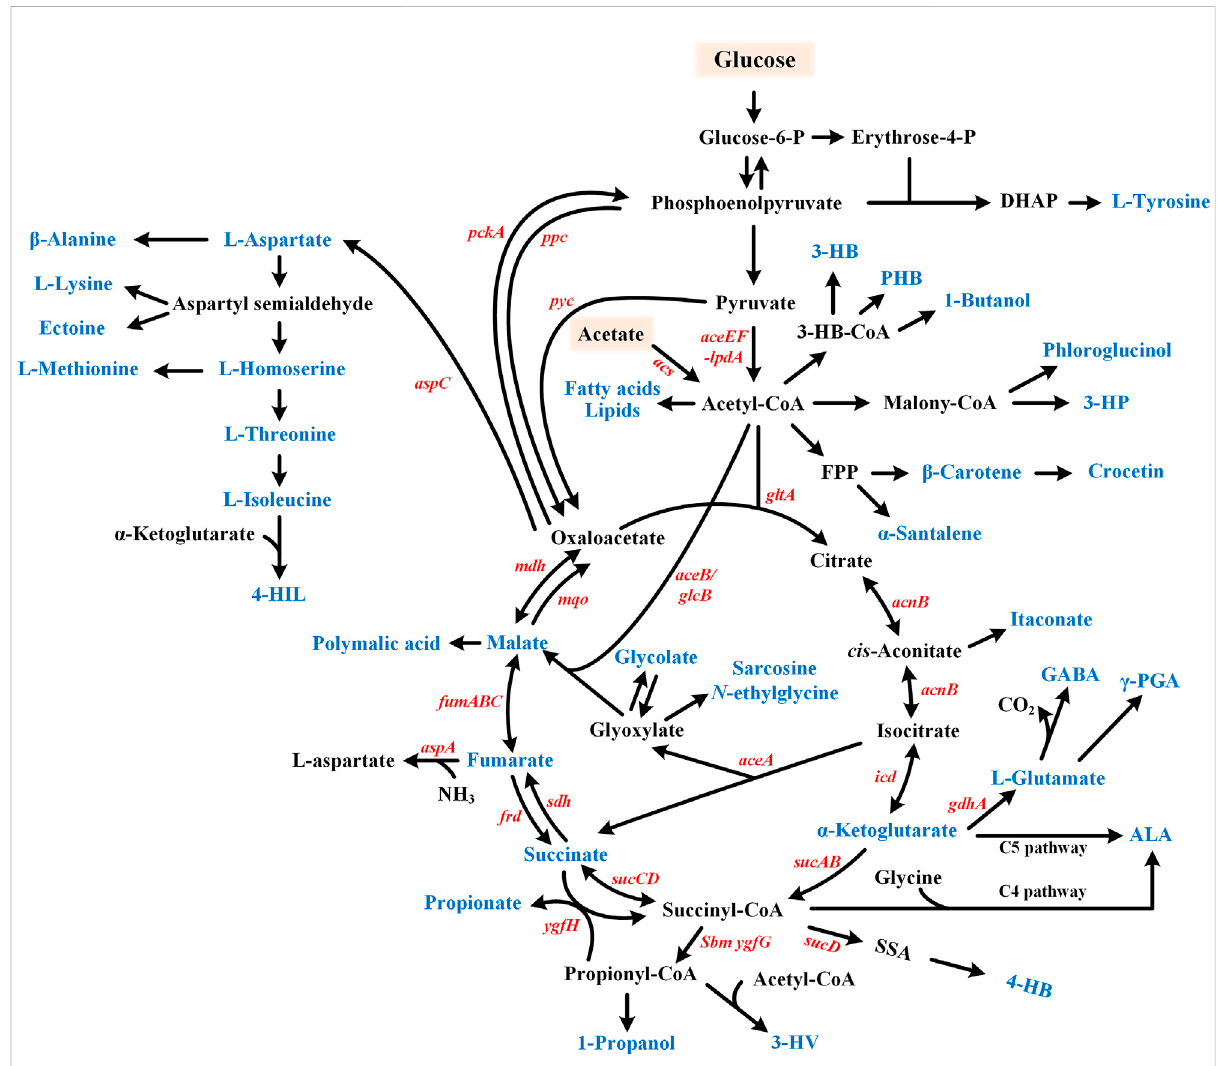
FIGURE 3 Metabolic pathway for the glyoxylate cycle involved chemicals production. Target products include organic acids, amino acids, fatty acid- relatedchemicals,etc.andareshowninblue.Glucoseoracetatecanbeusedassubstrates.GABA, γ -aminobutyricacid;4-HIL,4-hydroxyisoleucine; ALA, 5-aminolevulinic acid; γ -PGA, Poly- γ -glutamic acid; 3-HB, 3-hydroxybutyrate; PHB, poly β -hydroxybutyric acid; 3-HP, 3-hydroxypropionate; 4-HB, 4-hydroxybutyrate; and 3-HV,